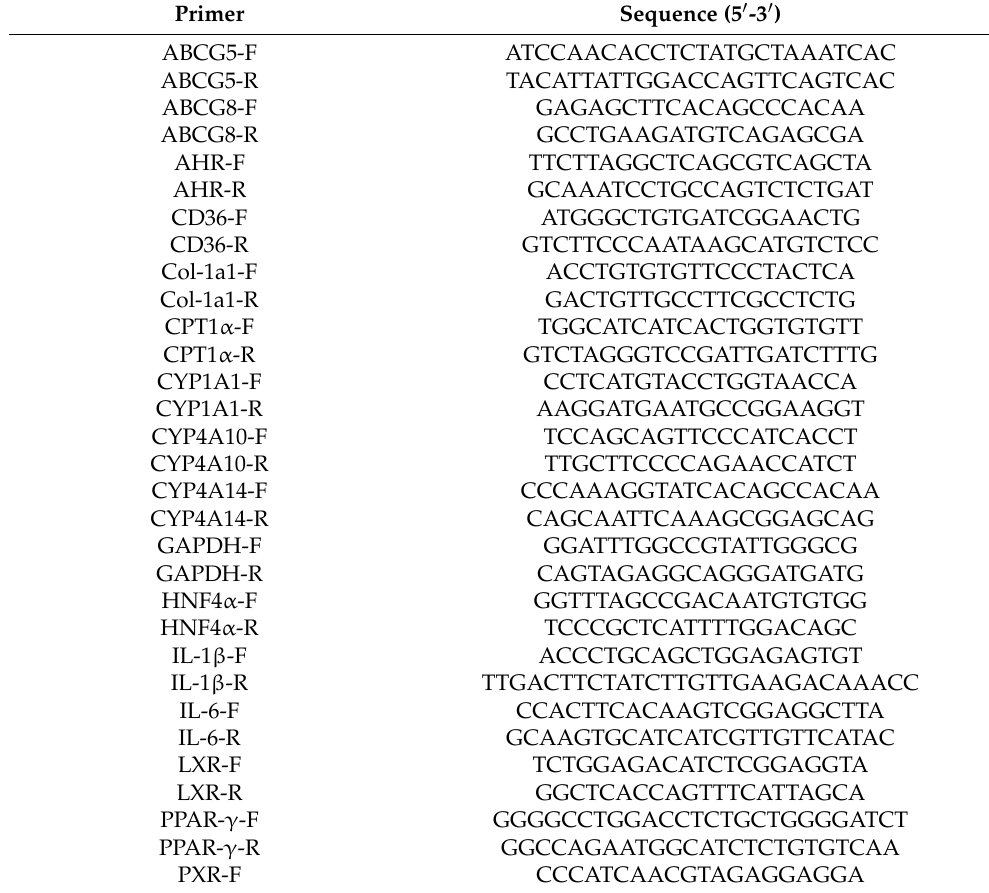
Table 1. Primer sequences used for RT-PCR analysis.